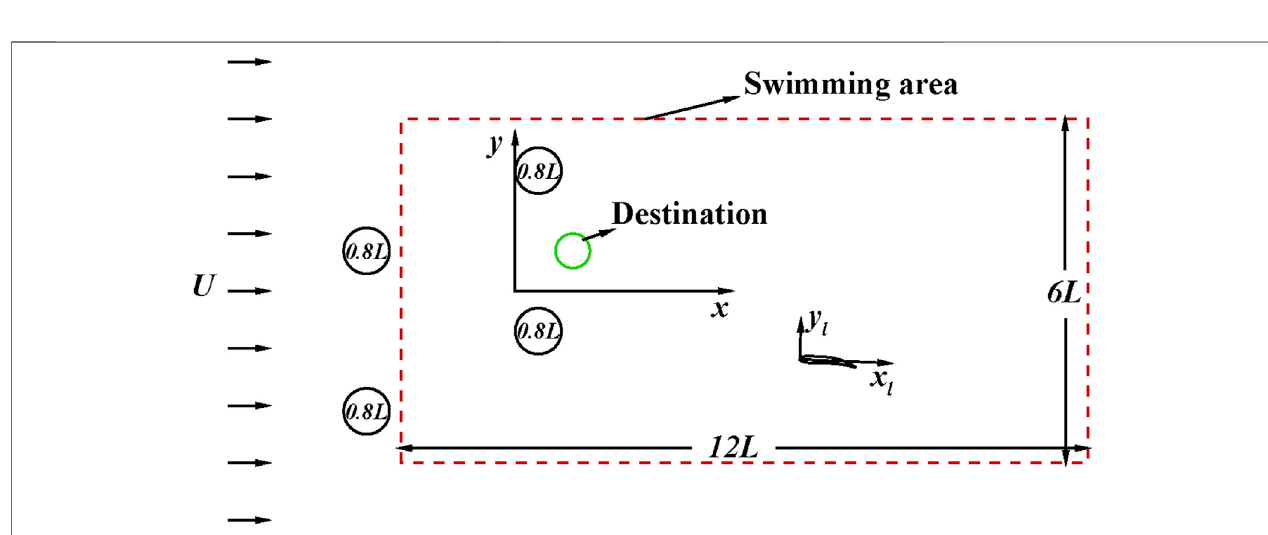
FIGURE 3 | The con fi ned domain of the